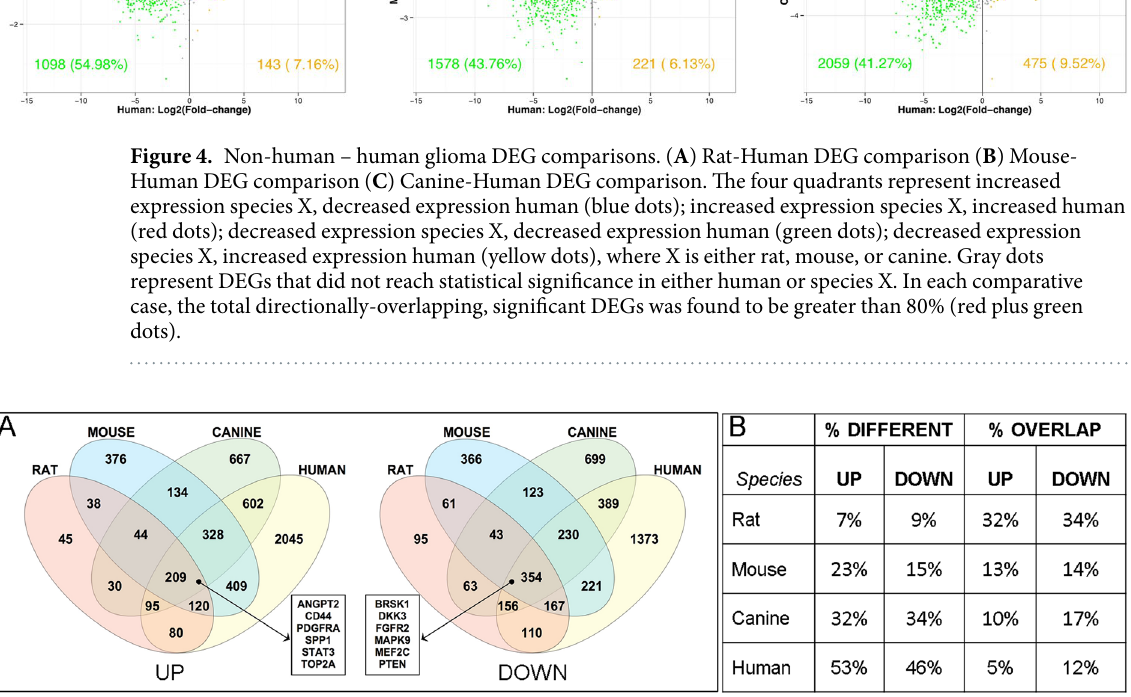
glioma-associated genes were entered into the DAVID function annotation algorithm (Supplementary Table 6). The enriched pathways determined from DAVID analysis were categorized into seven groups, including